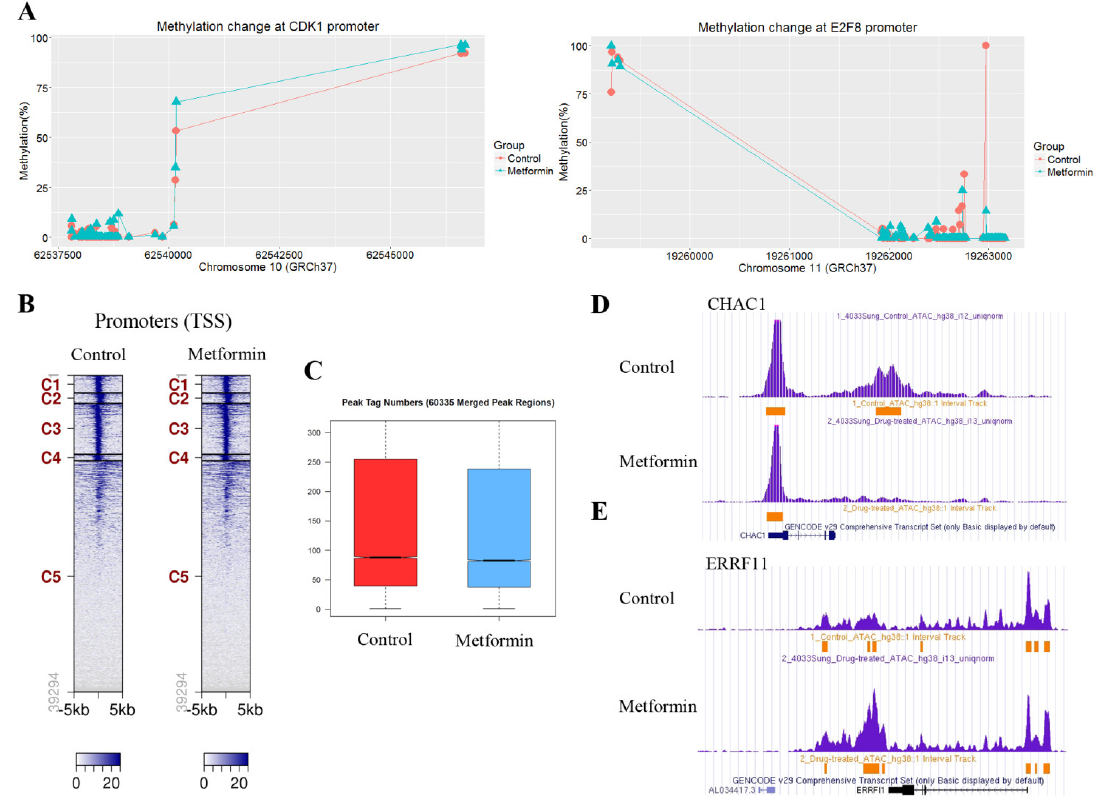
Figure 5. Effects of metformin on DNA methylation and chromatin accessibility. Alterations to DNA methylation and chromatin accessibility in H1299 cells treated with metformin or left untreated as controls were analyzed by the SureSelect Methyl-Seq Target System and ATAC-seq, respectively. ( A ) The methylation levels of CpGs at the promoter regions of CDK1 (left) and E2F8 (right) were compared between untreated and metformin-treated cells. ( B ) Heatmaps from the ATAC-seq analysis show the tag distribution in a 5-kb window in cells treated with metformin and left untreated. The promoter regions were grouped into five clusters by the bigWIG metrics program. ( C ) The peak tag number in the total merged peak regions was compared between cells treated and untreated with metformin. ( D , E ) The regions with significantly up- or downregulated chromatin accessibility in response to metformin were identified using the cutoff value |Log2 Ratio| ≥ 1. The images show that regions with severely downregulated ( D ) or upregulated ( E ) chromatin accessibility in response to metformin are located outside the promoter areas of the CHAC1 and ERRFI1 genes. Peaks indicate read count